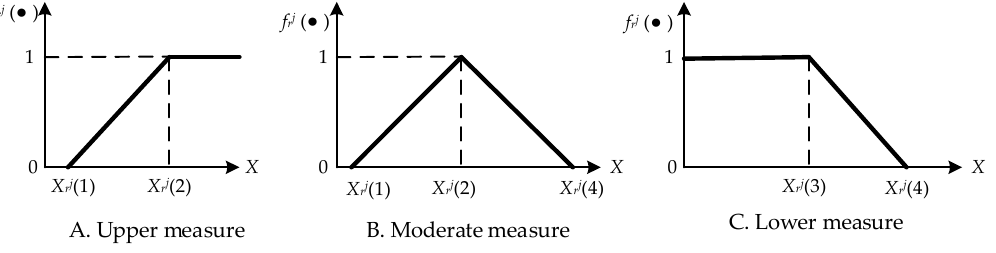
Figure 6. Typical whitenization function for the quality sorting problem.